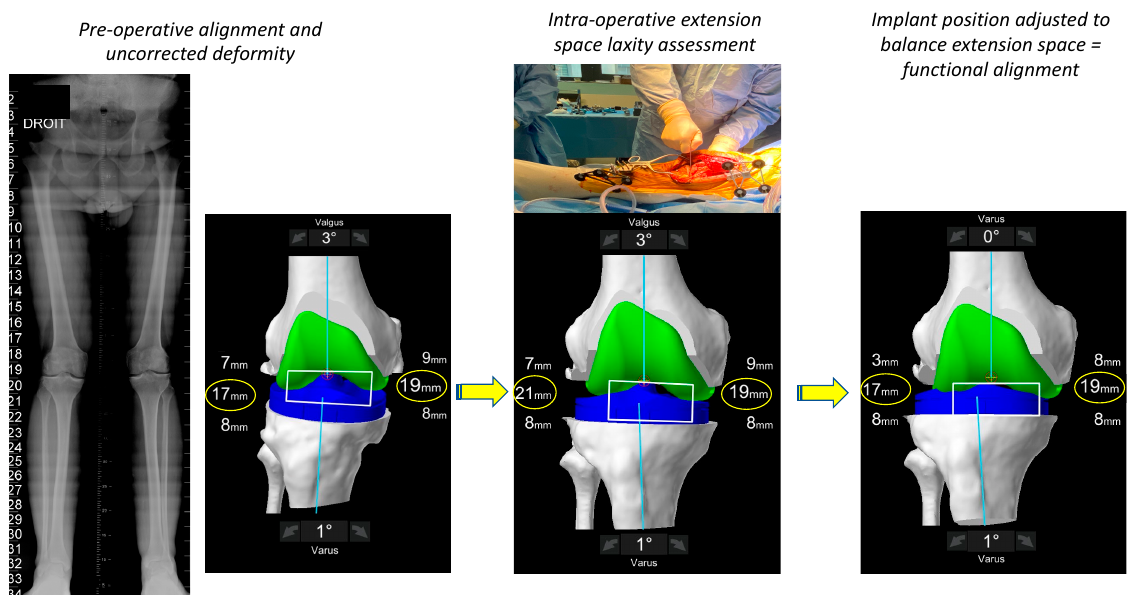
Figure 3. Intra-operative assessment of the extension space. The limb is placed in a corrected position and the robot ‘captures’ the pose. The plan will deliver extension gaps of 18 mm laterally and 17 mm medially. In order to achieve balanced compartments, the plan is modified in this case by decreasing the femoral valgus.